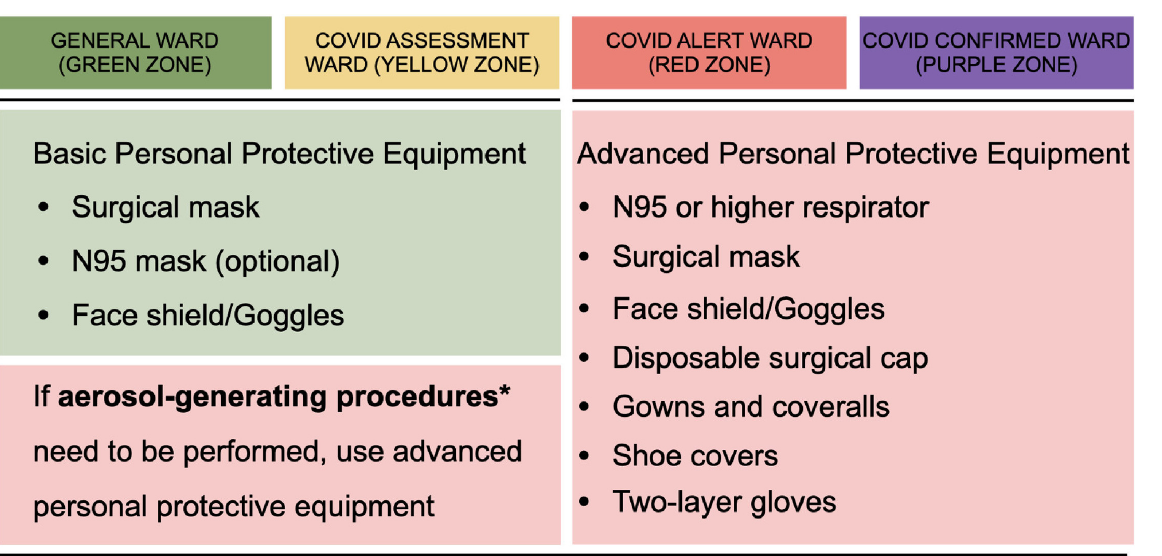
Fig 3. Recommendation of personal protective equipment for medical staff in different admission